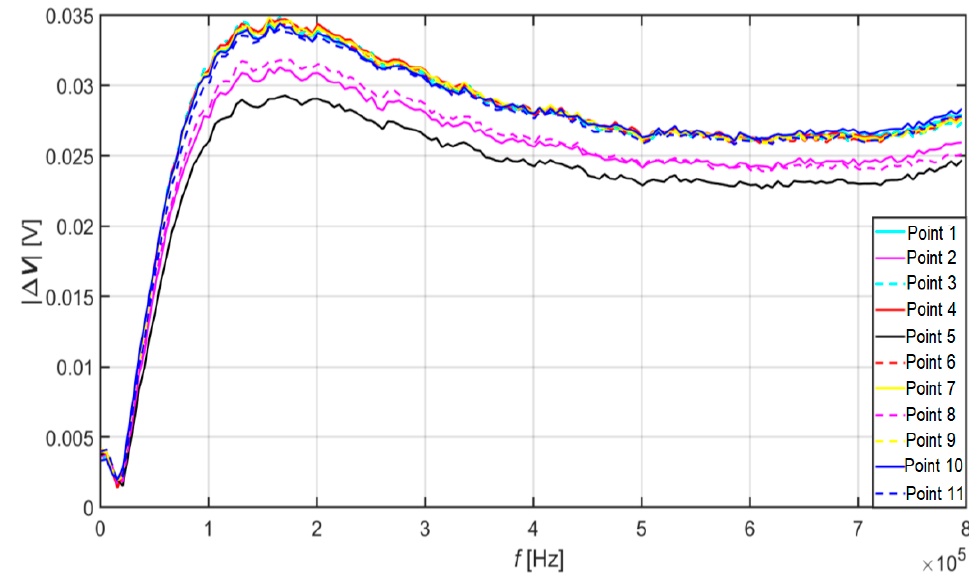
Figure 6. Graph of the absolute value of the voltage phasor of Specimen 2 corrosion crack.